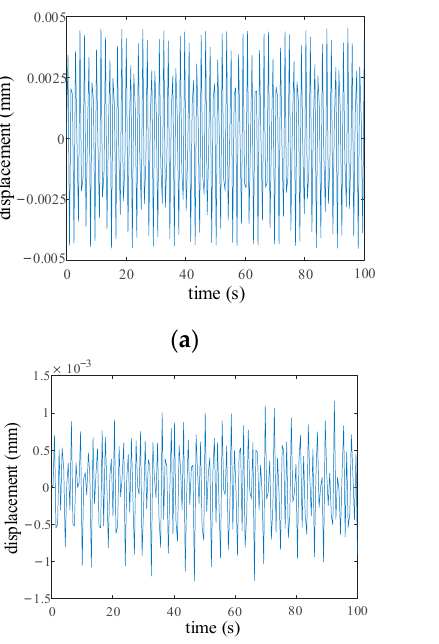
( b ) Figure 9. The time domain response of the carrier in the third stage under different loads. ( a ) Vertical displacement Y c3 of the carrier under 50% load; ( b ) vertical displacement Y c3 of the carrier under 150% load.